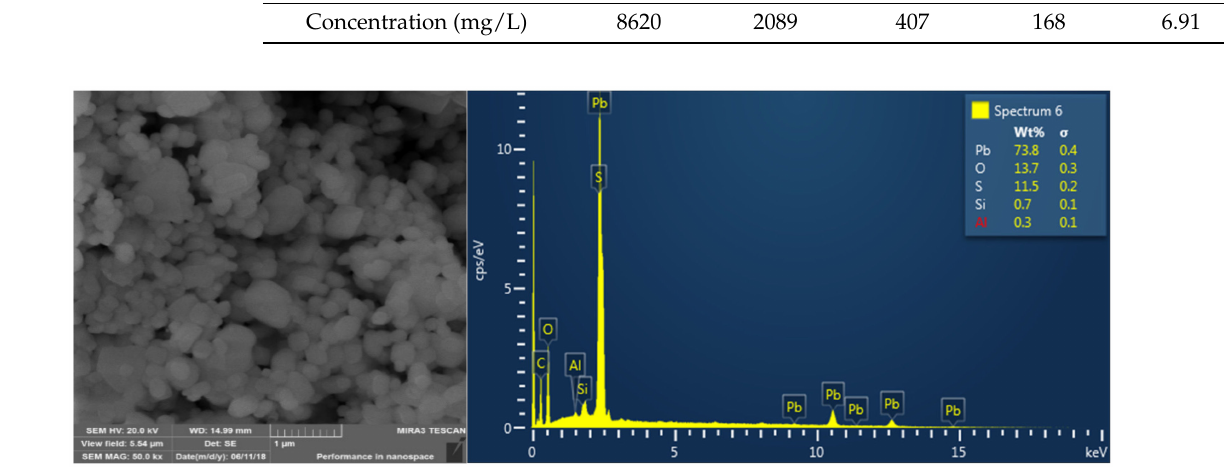
Figure 6. SEM-EDS of solid residue after CAF dust leaching.